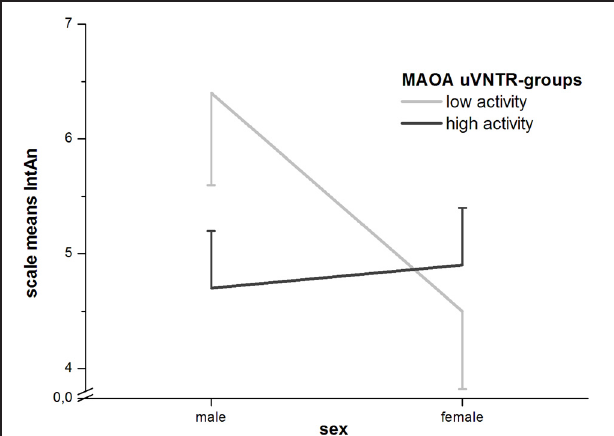
FIGURE 1 | Sex by MAOA-uVNTR-interaction for IntAn (with standard errors of the means).